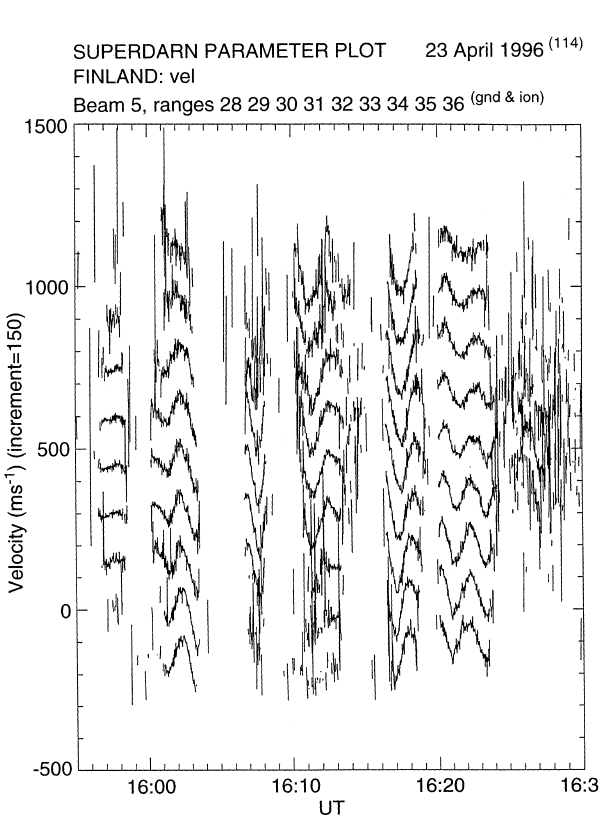
Fig. 5. Stacked time series of Finland line-of-sight velocity data for nine 15 km range gates (gates 28–36, ranges 900–1035 km). Range gates 28–35 are used to derive the wave parameters in Fig. 7